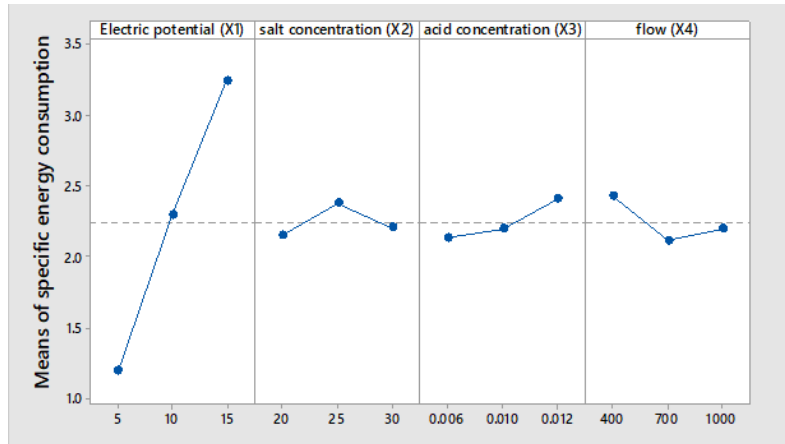
Figure 8. Main Effect Plot for Means of specific energy